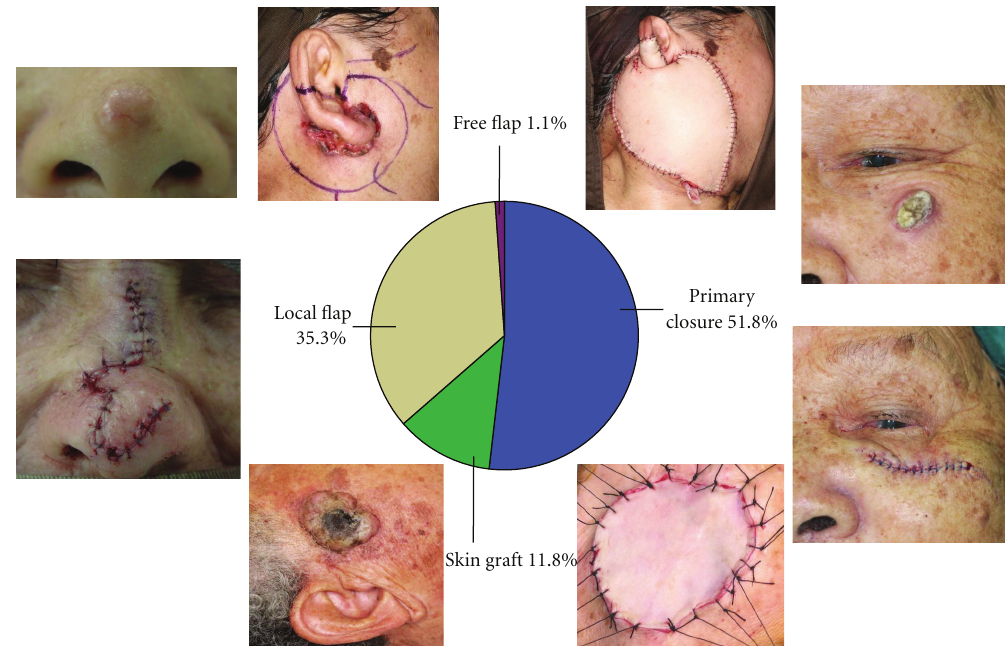
Figure 3: Methods of wound closure. From right to left in a clockwise direction: an 80-year-old lady with a pigmented ulcerative BCC over her left cheek, pathology excised with a 2 mm margins, wound closed primarily; a 60-year-old lady with a pigmented ulcerative BCC over her right preauricular region, the wound was too extensive for primary closure after tumour resection, and yet there was insu ffi cient tissue for local flap reconstruction, hence a full thickness skin graft was harvested from the postauricular region for wound coverage; a 70-year-old lady with a nonpigmented nodular BCC over her nose tip. Excision was performed with a 2mm margin followed by reconstruction with a bilobed flap; a 50-year-old lady who presented with a pigmented ulcerative BCC over her right auricle which invaded into the superficial and deep lobes of the parotid gland; facial nerve was intact. Wide local excision of tumour with total conservative parotidectomy was performed. The defect was reconstructed with a free anterolateral thigh myocutaneous